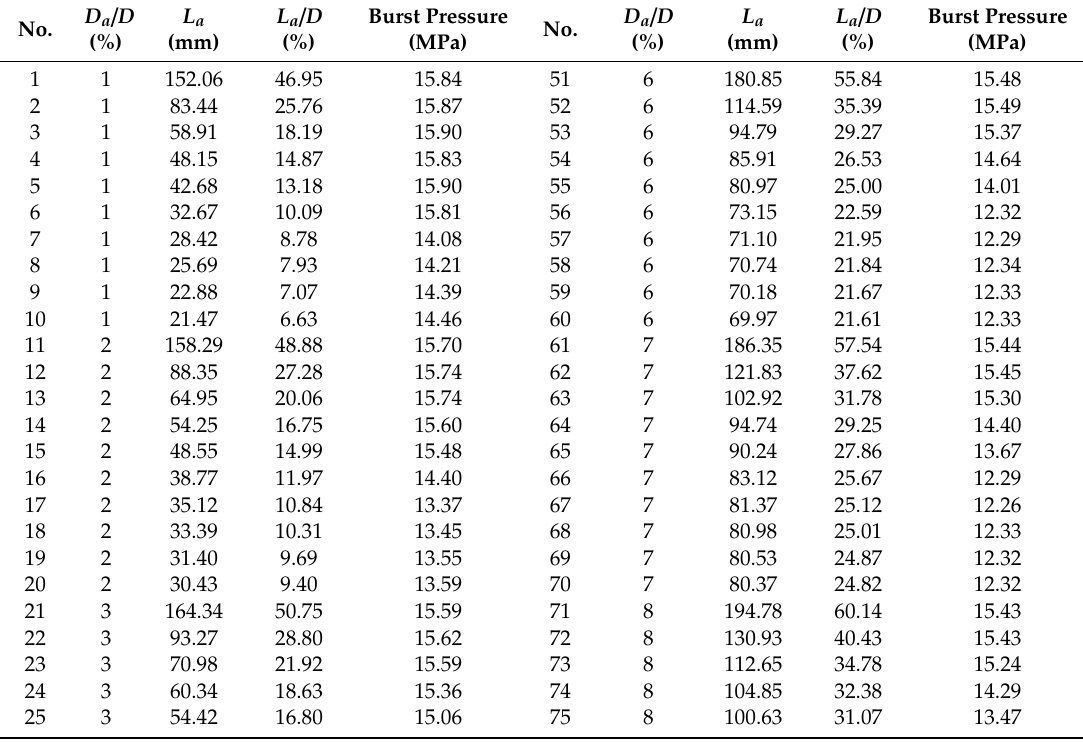
Table A1. La , La / D , Da , Da / D and burst pressure for the FEA based parametric study